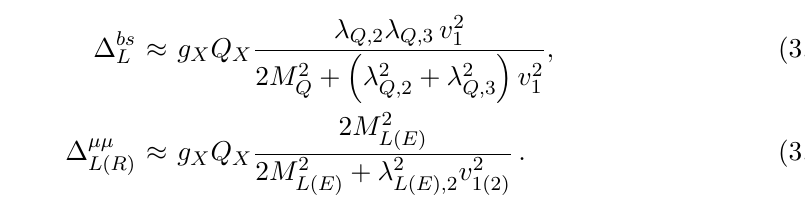
and C (cid:22) Wilson coe(cid:14)cients (eqs. (3.4) 9 ; NP 10 ; NP